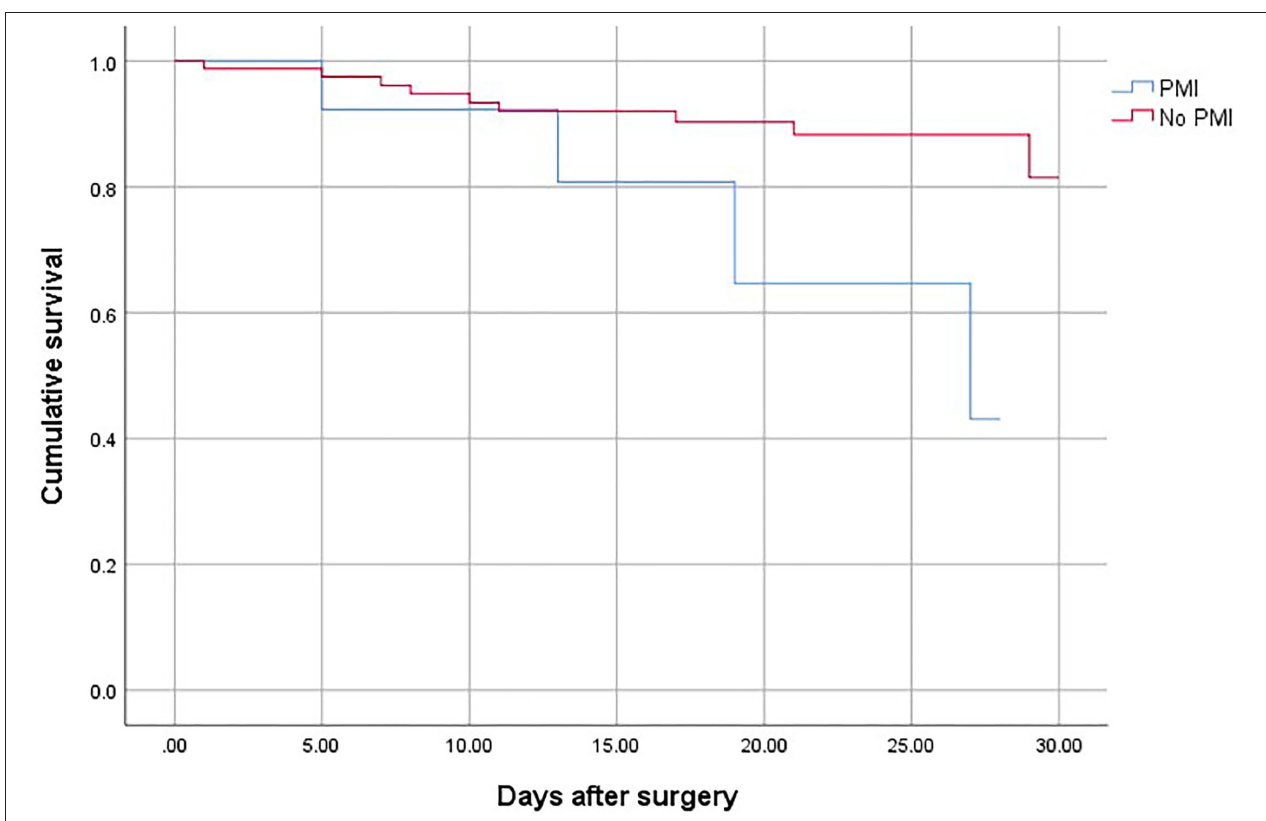
FIGURE 2 | The 30-day mortality for surgical patients with and without